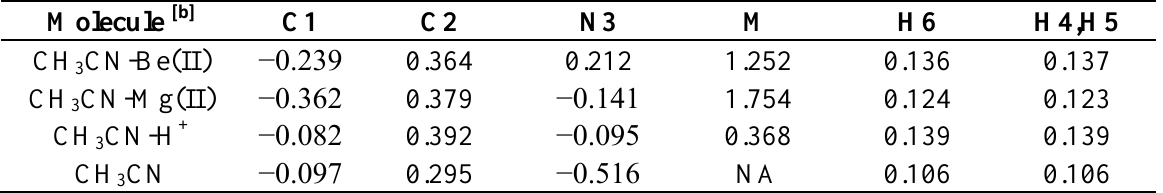
Table 6. Mulliken charge [a] of acetonitrile and its complexes with Be(II), Mg(II) and H + .